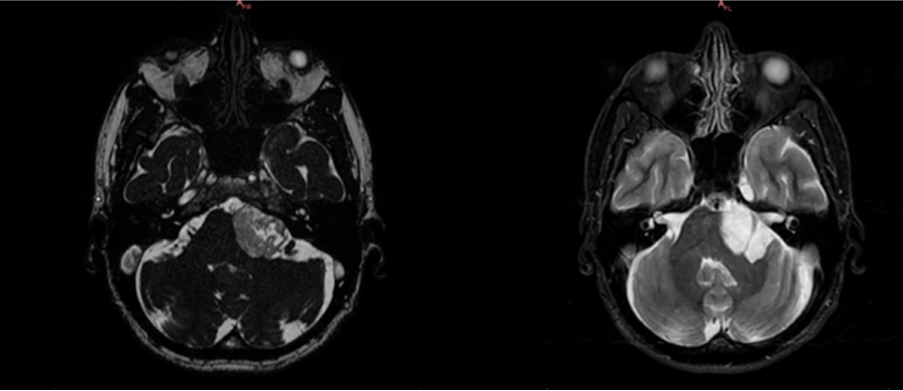
Figure 3. MRI scans before surgery. Notes: T1 weighted sequence ( left ) and SE-T2 weighted scan ( right ). Cystic type formation compressing the brain stem and deforming the angle of the ipsilateral cerebellar peduncle.